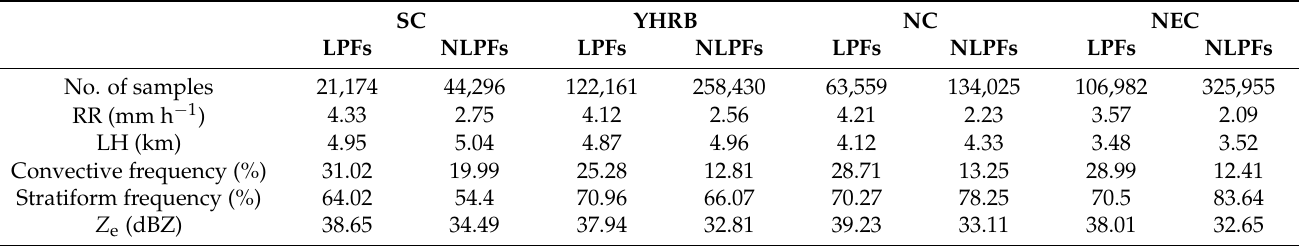
Figure 2. Frequency pattern in two-dimensional space of D m and N w at 2 km above the MSL over ( a , e ) SC, ( b , f ) YHRB, ( c , g ) NC and ( d , h ) NEC for LPFs (upper panel) and NLPFs (lower panel) during summer in the time period 2014–2021. D m and N w denote the mean values of D m and N w , respectively. The 5% and 50% contours are indicated by black and white solid lines, respectively. Table 1. Total number of DPR pixels, the mean near-surface RR, the LH, the convective and stratiform frequency, and the reflectivity at 2 km altitude above the MSL for LPFs and NLPFs over SC, YHRB, NC and NEC during summer in the time period